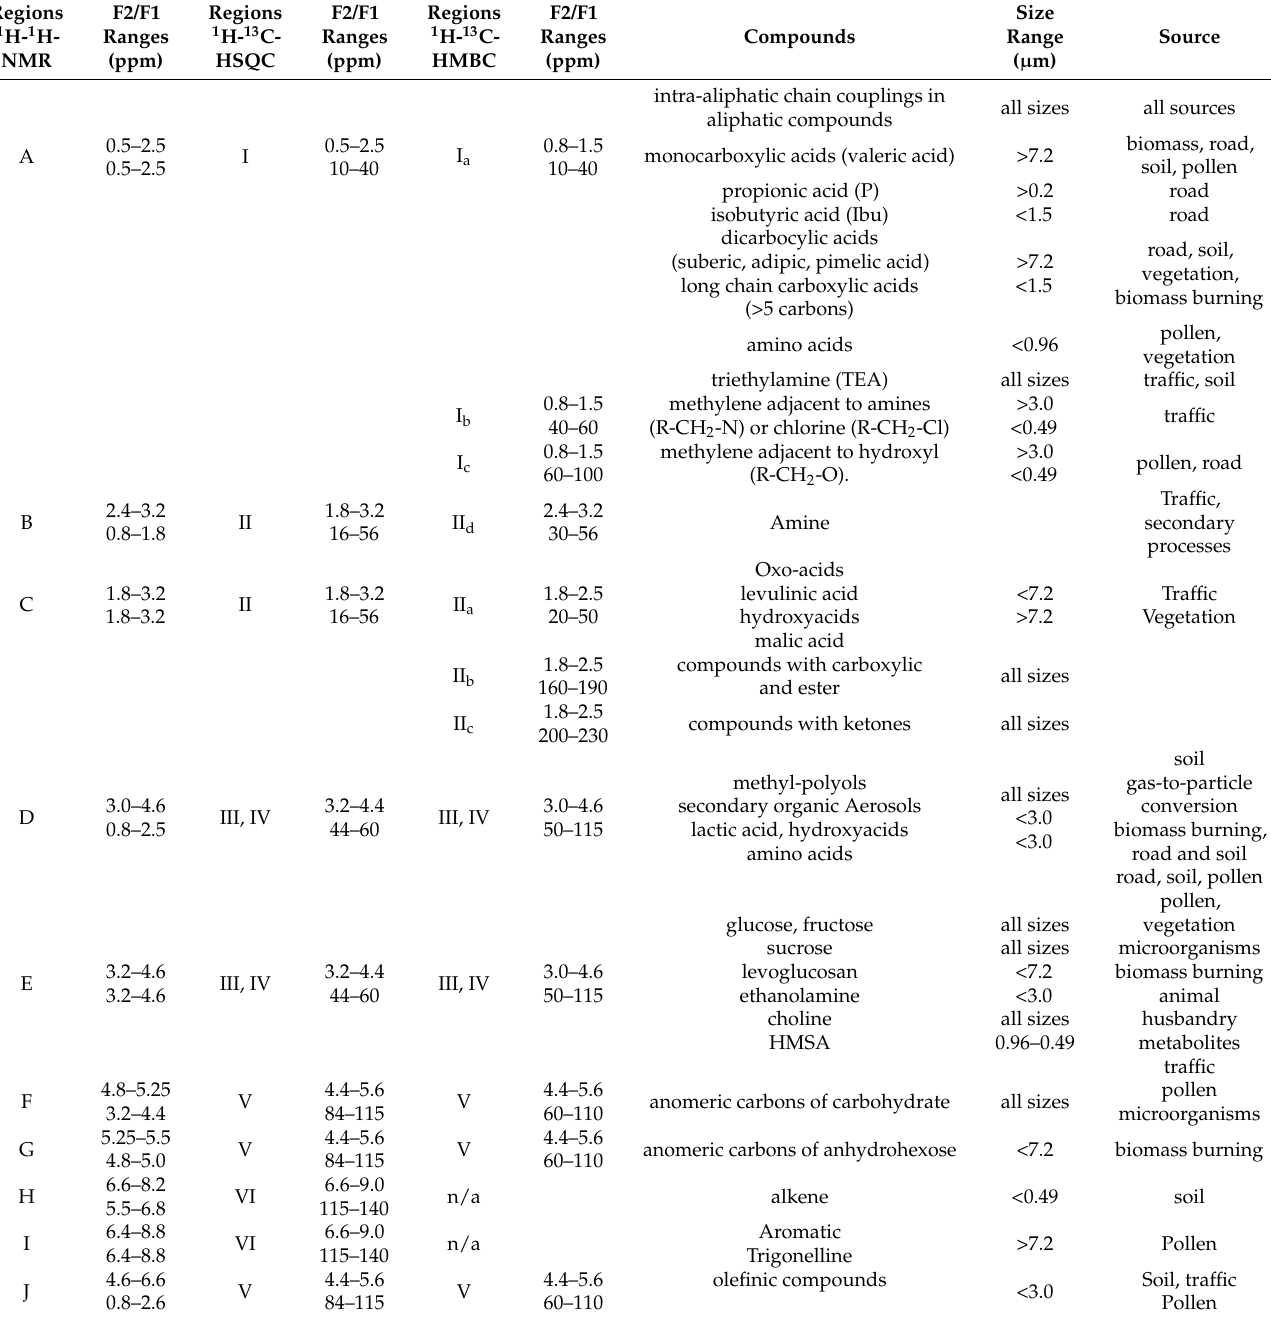
Table 2. Chemical shift ranges of the regions defined from the 2D-NMR spectra, the compounds predominant in these regions, their size range, and